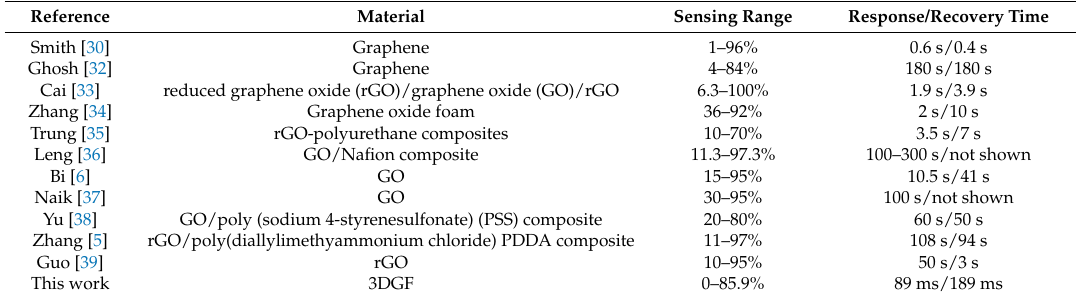
Table 1. Comparison of different reported humidity sensors with graphene series materials.